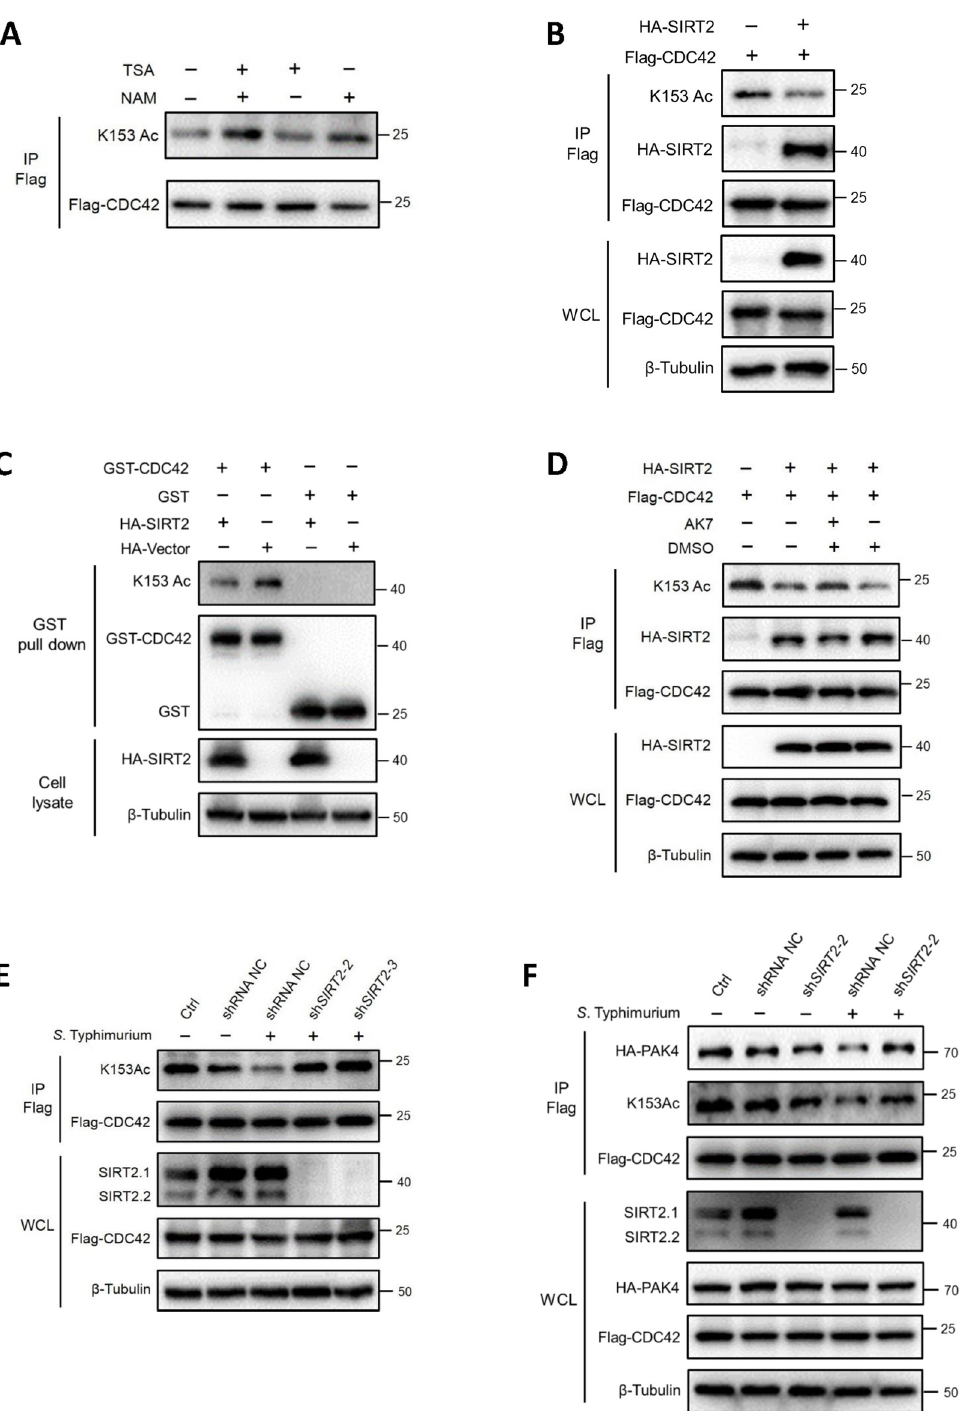
Fig 3. CDC42 K153 is deacetylated by SIRT2. (A) CDC42 K153 acetylation is regulated by SIRT family deacetylases. HEK293T cells transfected with Flag-CDC42 were treated with the deacetylase inhibitors TSA (2 μ M) and NAM (10 mM) for 16 h before harvesting. K153 acetylation was determined by IP/WB. (B) SIRT2 decreases K153 acetylation in vivo . Overexpression of SIRT2 significantly decreases K153 acetylation. Flag-CDC42 was co-transfected with or without HA-SIRT2 into HEK293T cells, and K153 acetylation was analyzed by IP with anti-Flag antibody and WB with anti- K153Ac antibody. (C) SIRT2 decreases K153 acetylation in vitro . Purified GST-CDC42 protein was incubated with the cell lysate of HEK293T cells expressing HA-SIRT2 or the control vector. K153 acetylation was determined by the GST pull-